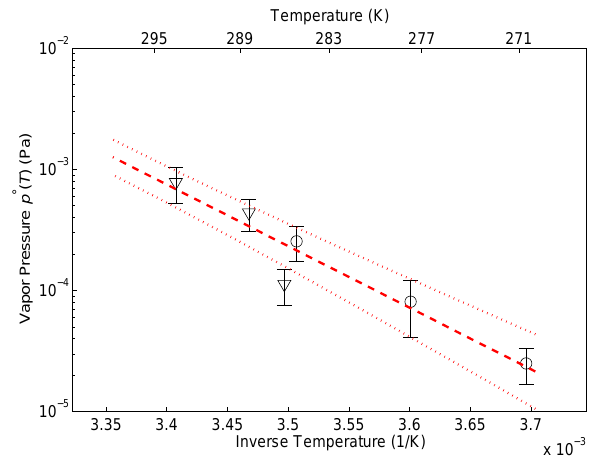
Fig. 3. Pure component vapor pressure p ◦ ,L of 2-methylmalonic acid (open symbols, denoting two different particles). Fit line (dashed) is to Eq. ( 5) with 2 σ error bounds shown as dotted